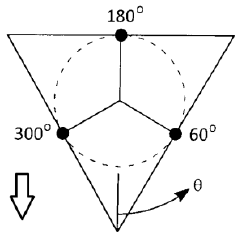
Figure 5. Angular locations of thermocouples and gravity direction.